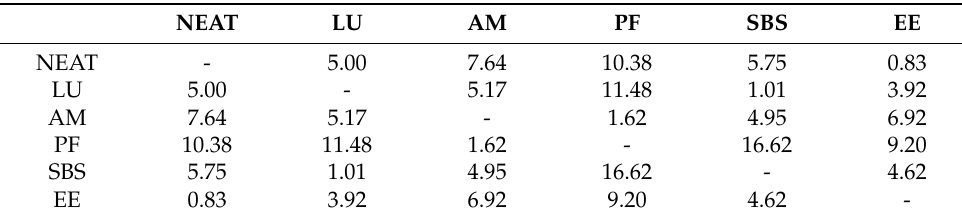
Table 10. Effect sizes dynamic modulus at the temperature of 21.1 ◦ C.